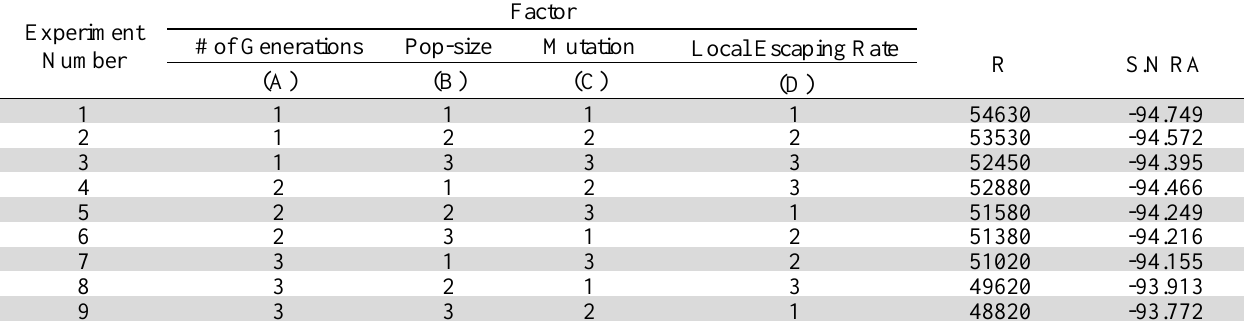
Results of implemeting the experiments for Taguchi